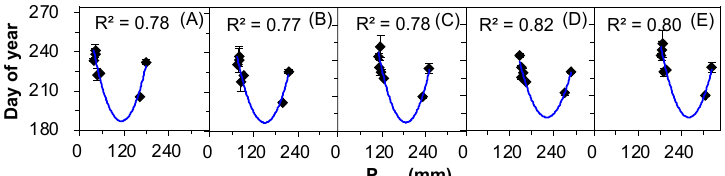
Figure 5. Correlations between the end of seed release (ESR) and summer cumulative precipitation (P sum ) in Nitraria tangutorum under ( A ) Ctrl, ( B ) +25%, ( C ) +50%, ( D ) +75%, and ( E ) +100% water addition treatments. The solid lines indicate p ≤ 0.05. There were marginally significant (+50%, 0.05 ≤ p ≤ 0.1, Figure 6C) or significant (con ‐ trol, +25%, +75%, +100%, all p ≤ 0.05, Figure 6A,B,D,E) downward quadratic relationships between the annual mean temperature (AMT) and DSR. No significant correlation was found between the other meteorological factors and DSR (F 2). Figure 6. Correlations between the annual mean temperature (AMT) and the duration of seed re ‐ lease (DSR) of Nitraria tangutorum under ( A ) Ctrl, ( B ) +25%, ( C ) +50%, ( D ) +75%, and ( E ) +100% water addition treatments. The solid lines indicate p ≤ 0.05, while the dashed line indicates 0.05 ≤ p ≤ 0.1. 2.5. The Correlations between Seed Release Events and the Other Phenological Events The inter ‐ annual ESR change did not correlate to any of the early ‐ season leaf pheno ‐ logical events, onset or end of leaf unfolding, under the water addition treatments (con ‐ trol, +25%, +50%, +75%, +100%) over the seven years (2012–2018) (all p > 0.05). Contrarily, the inter ‐ annual OSR changes significantly correlated with the preceding fruit ripening events, i.e., fruits developing red colors, under all treatments (control, +25%, +50%, +75%, +100%, all p < 0.05, Figure 7) over the seven years (2012–2018).